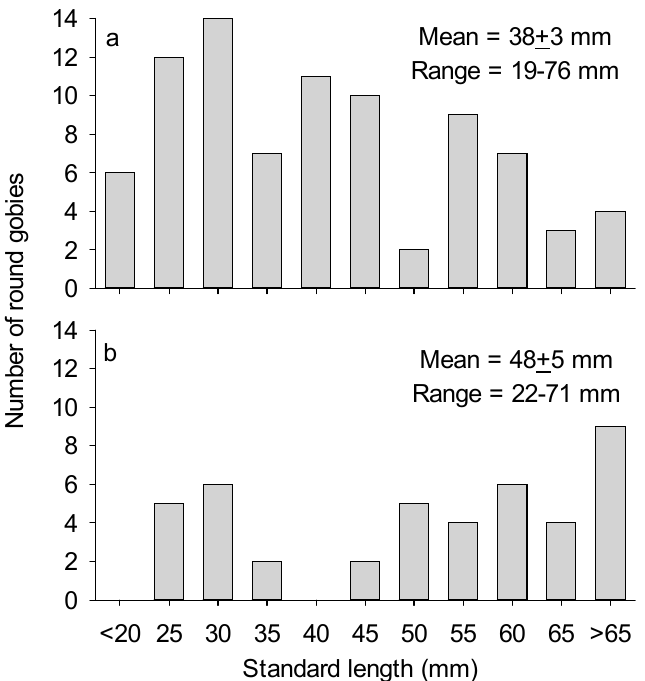
Figure 1. Plot ( a ): length-frequency distribution of N. melanostomus appearing in the video. Plot ( b ): length-frequency distribution of N. melanostomus exhibiting rotational feeding in the video; some fish were observed exhibiting this behavior more than once.